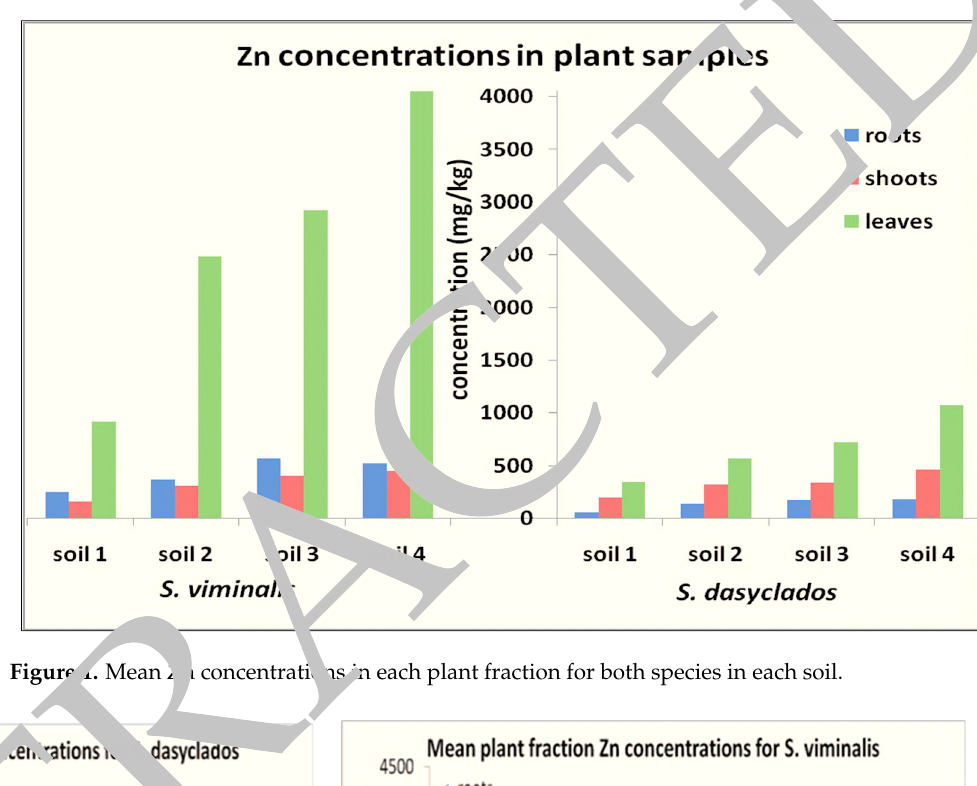
Figure 1. Mean Zn concentrations in each plant fraction for both species in each soil.